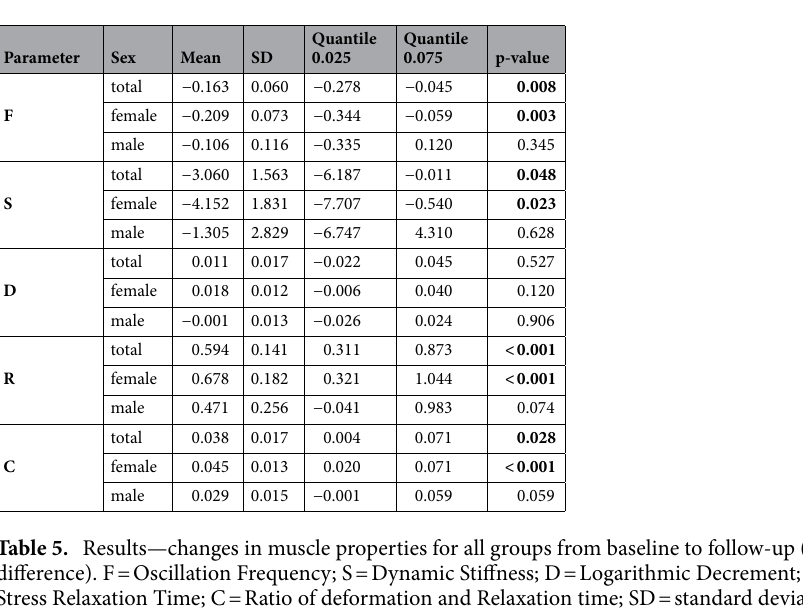
Parameter Sex Mean